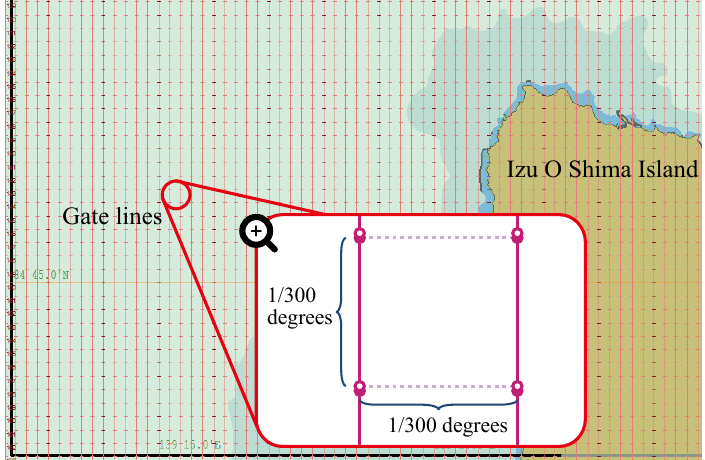
Figure 2. Gate line settings for the target area.